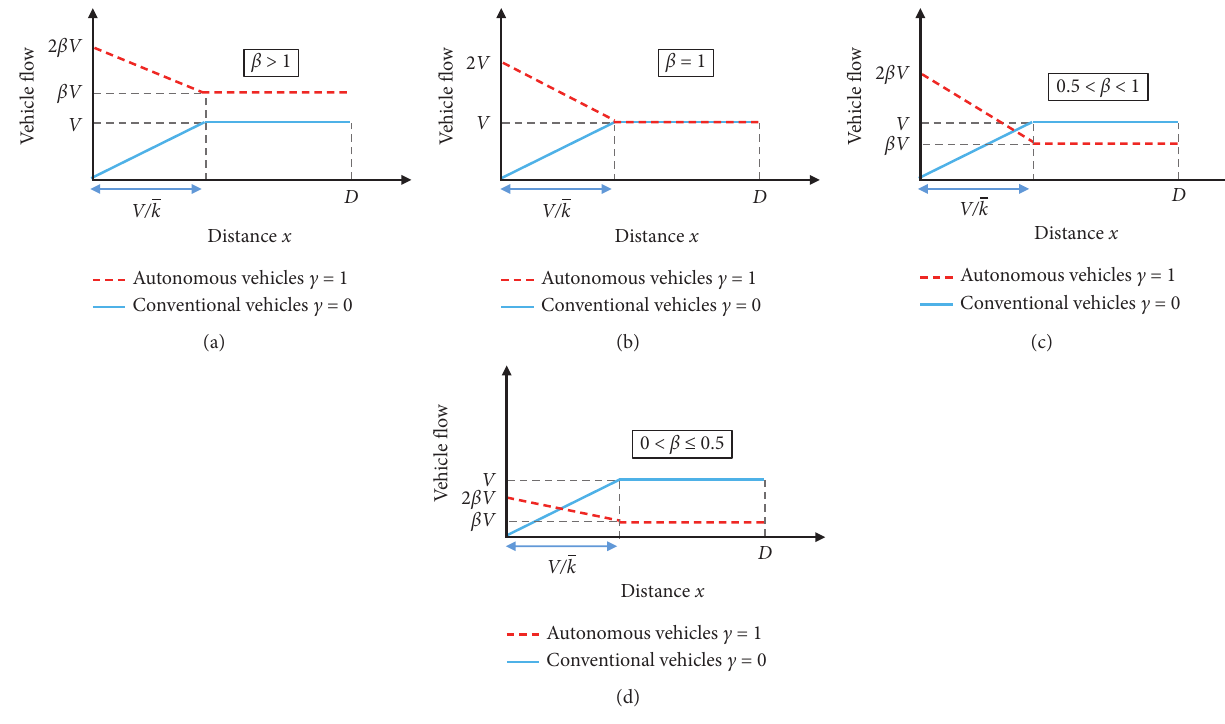
Figure 9: Traffic flow at (a) β > 1, (b) β � 1, (c) 0 . 5 < β < 1, and (d) β < 0 . 5.